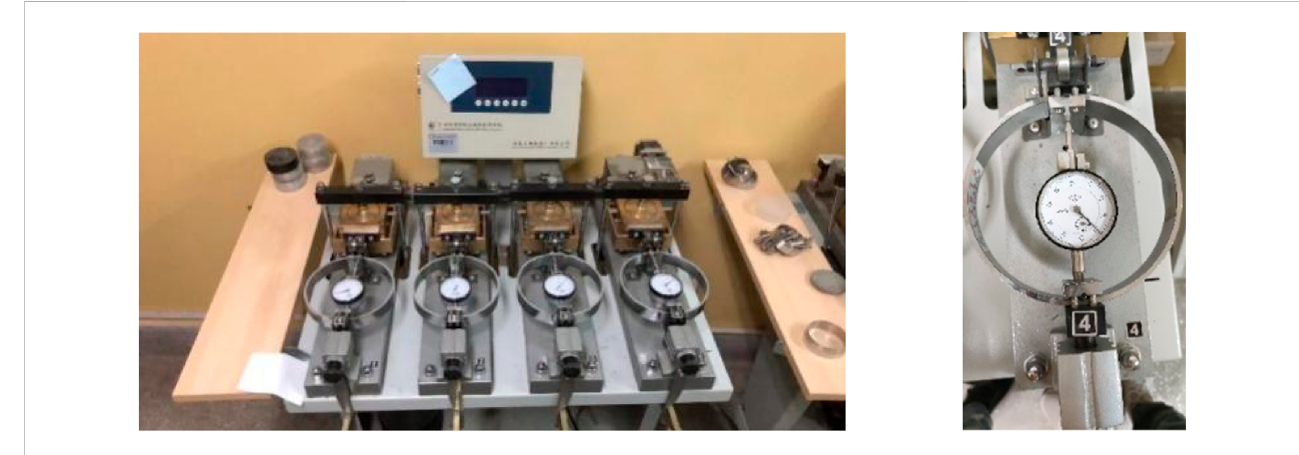
FIGURE 2 ZJ strain-controlled direct shear instrument.